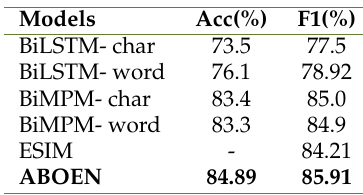
Table 2. Experimental results on NCSS dataset. Table 3. Experimental results on LCQMC dataset.